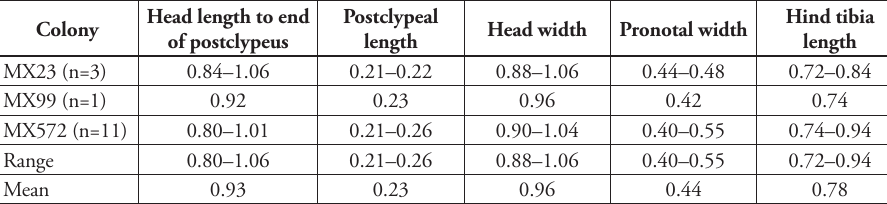
Table 2. Measurements (mm) of Parvitermes mexicanus comb. n. workers.